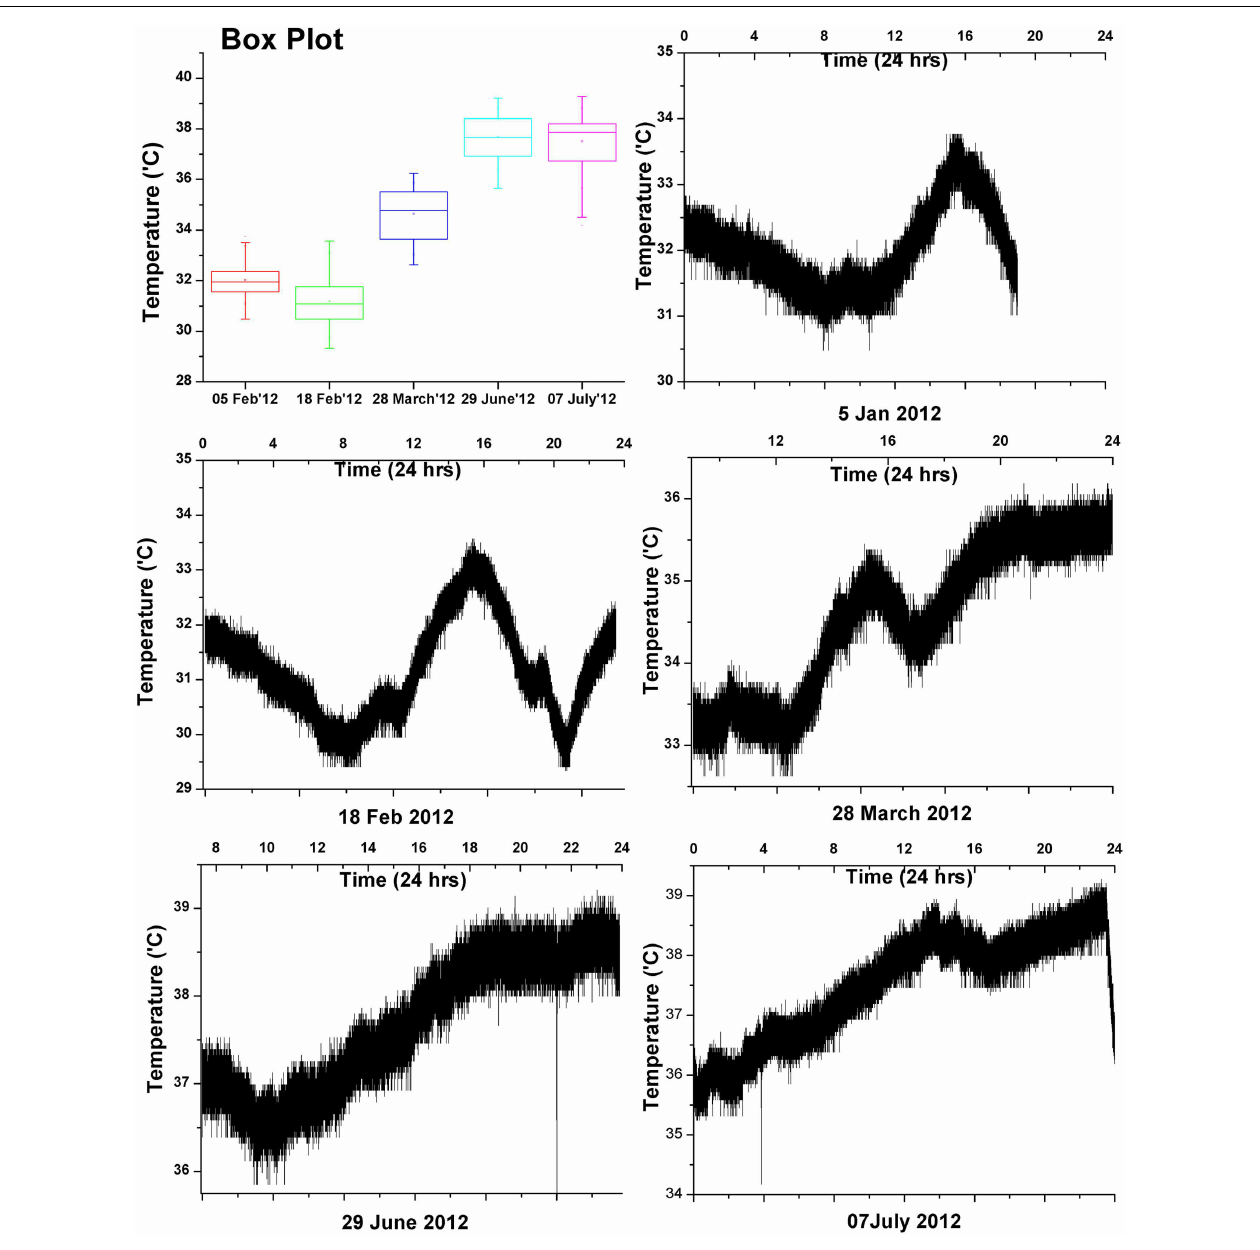
FIGURE 7 | Inlet water temperature variation for experimental natural circulation loop at BARC